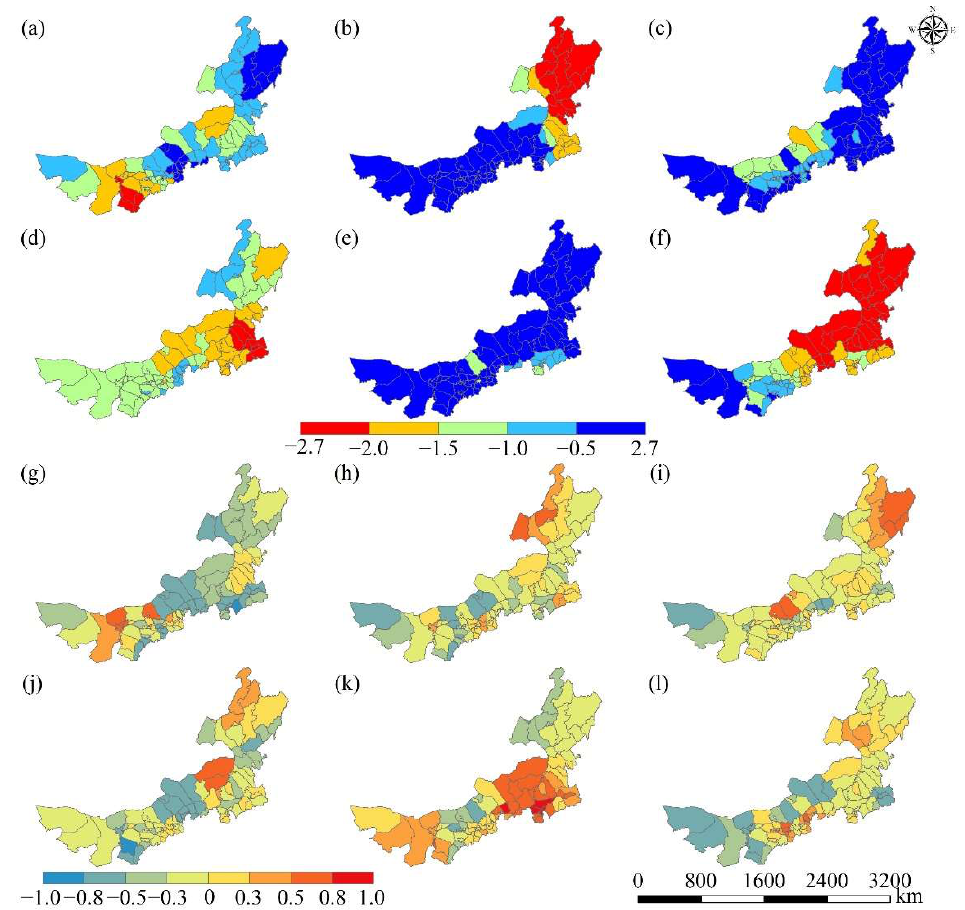
Figure 9. The distribution of SPEI in spring and summer of 2000, 2003, 2007 and the correlation between SPEI and small livestock population. ( a – c ) SPEI in spring of 2000, 2003 and 2007; ( d – f ) SPEI in summer of 2000, 2003 and 2007; ( g – i ) Correlation between SPEI and small livestock population in spring of 2000, 2003 and 2007; ( j – l ) Correlation between SPEI and small livestock population in summer of 2000, 2003 and 2007.